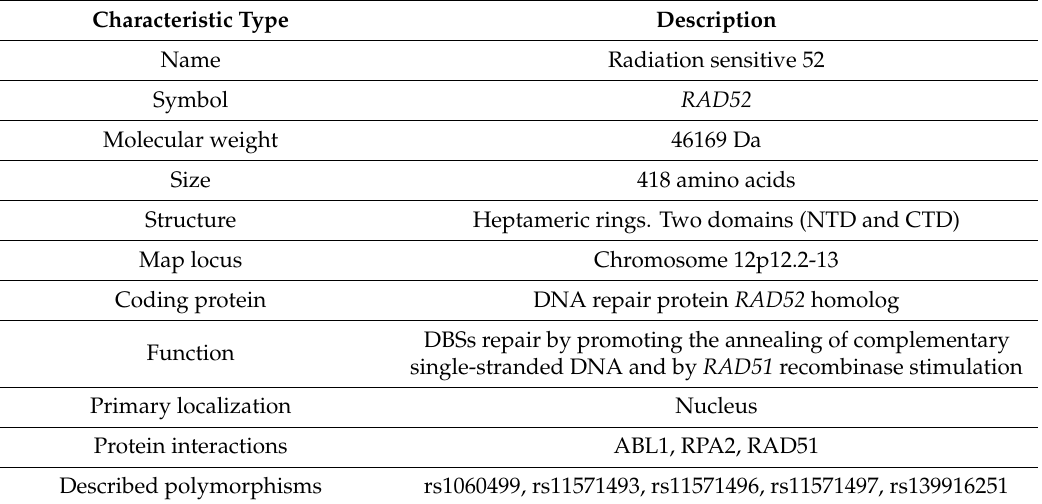
Table 1. Characteristics of the gene RAD52